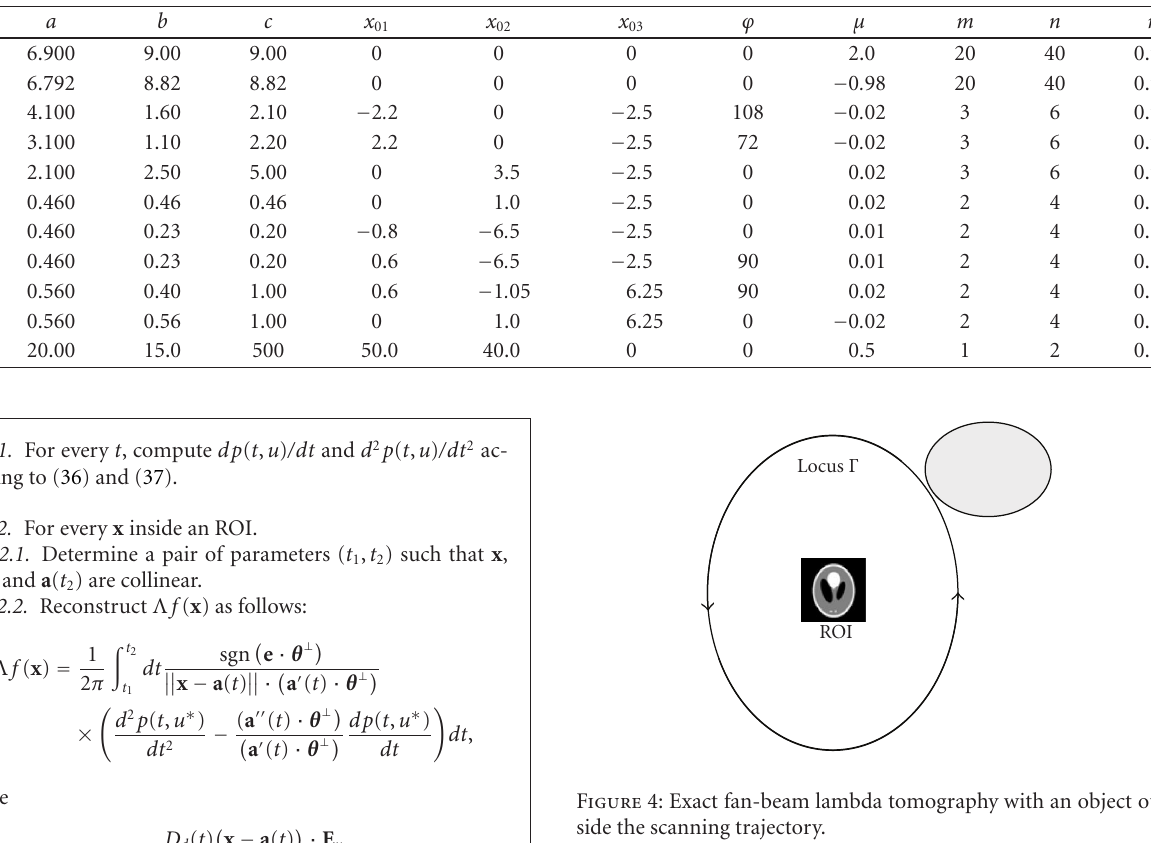
Table 1: Parameters of the DSLP.